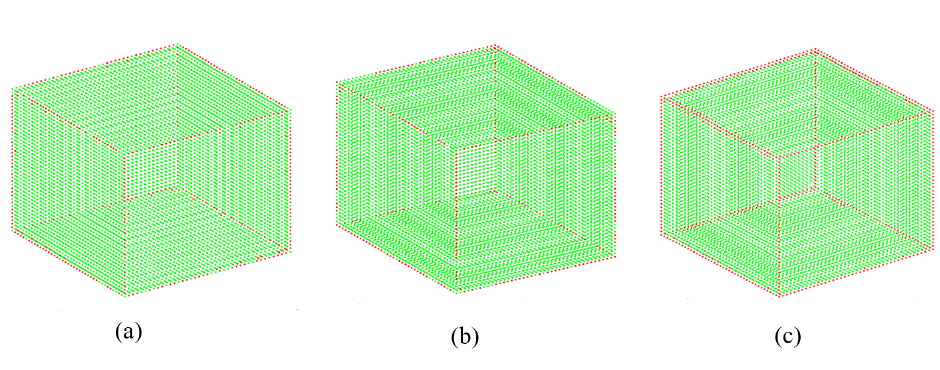
Figure 15. Comparing results on a synthetic cube shape by the ( a ) AGPN [16], ( b ) Chen [17], and ( c ) proposed methods. Green represents planar points, and red represents fold points.